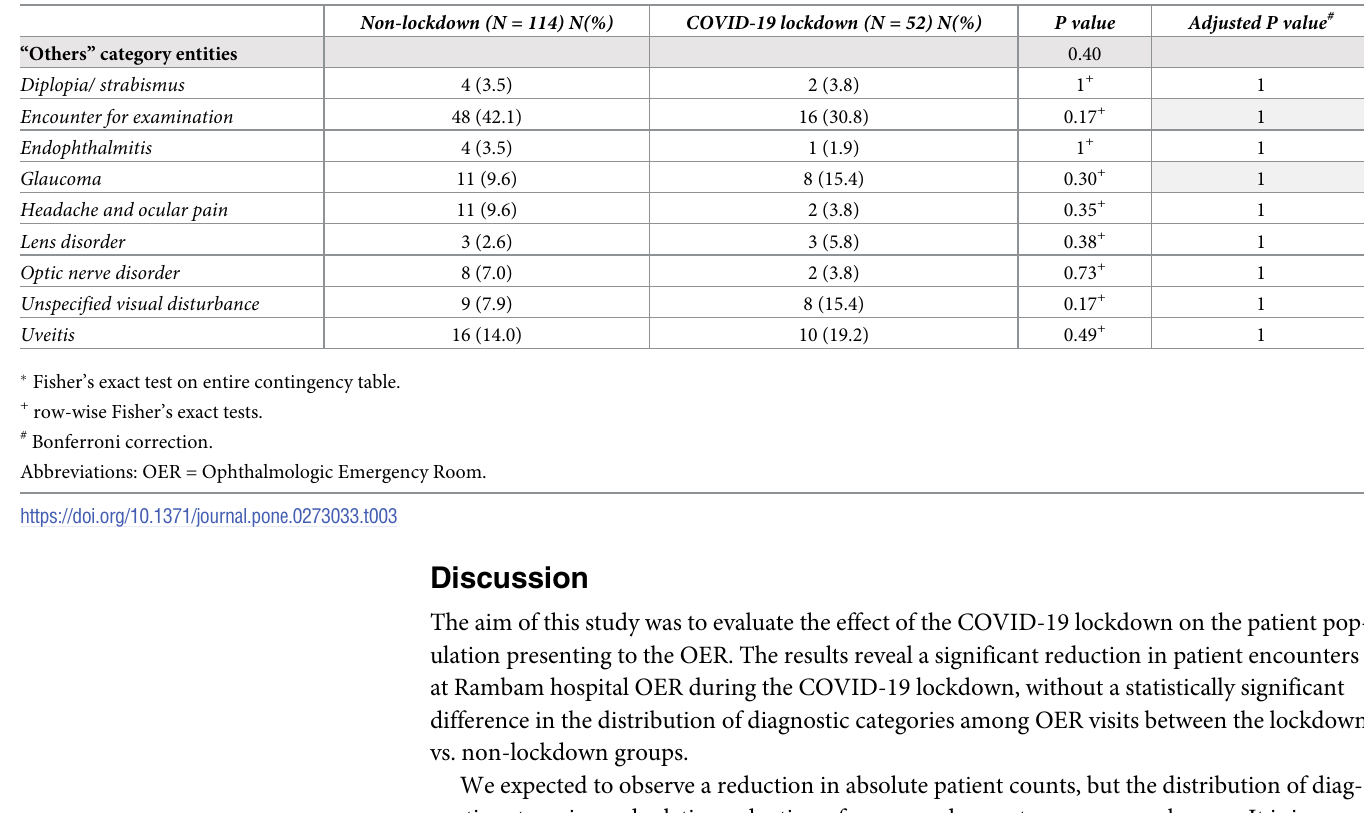
Table 3. Distribution of diagnostic entities included in the “other” diagnostic category between OER visits in the non-lockdown and COVID-19 lockdown